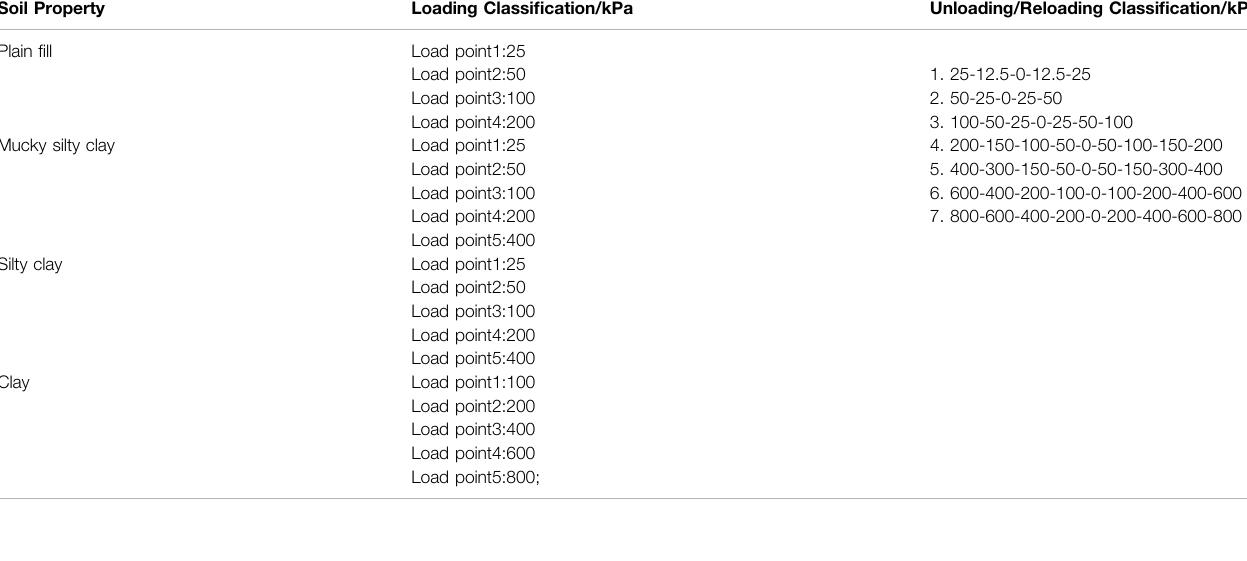
TABLE 1 | Soil compression-rebound test conditions.